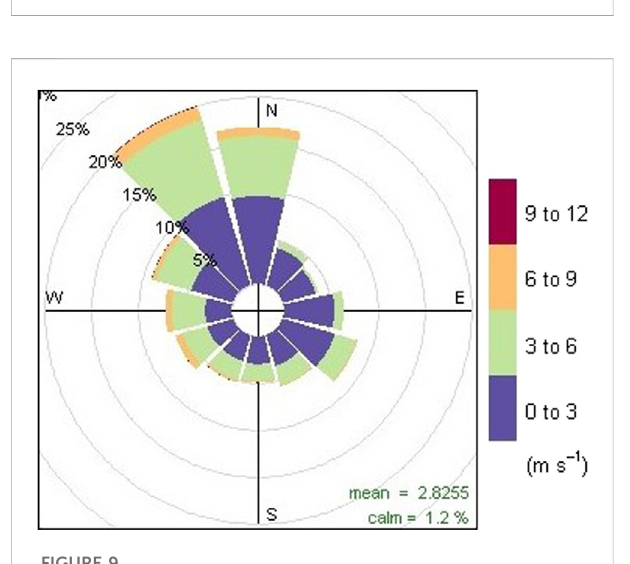
Weather station wind rose period 10/2018 to 10/2019.